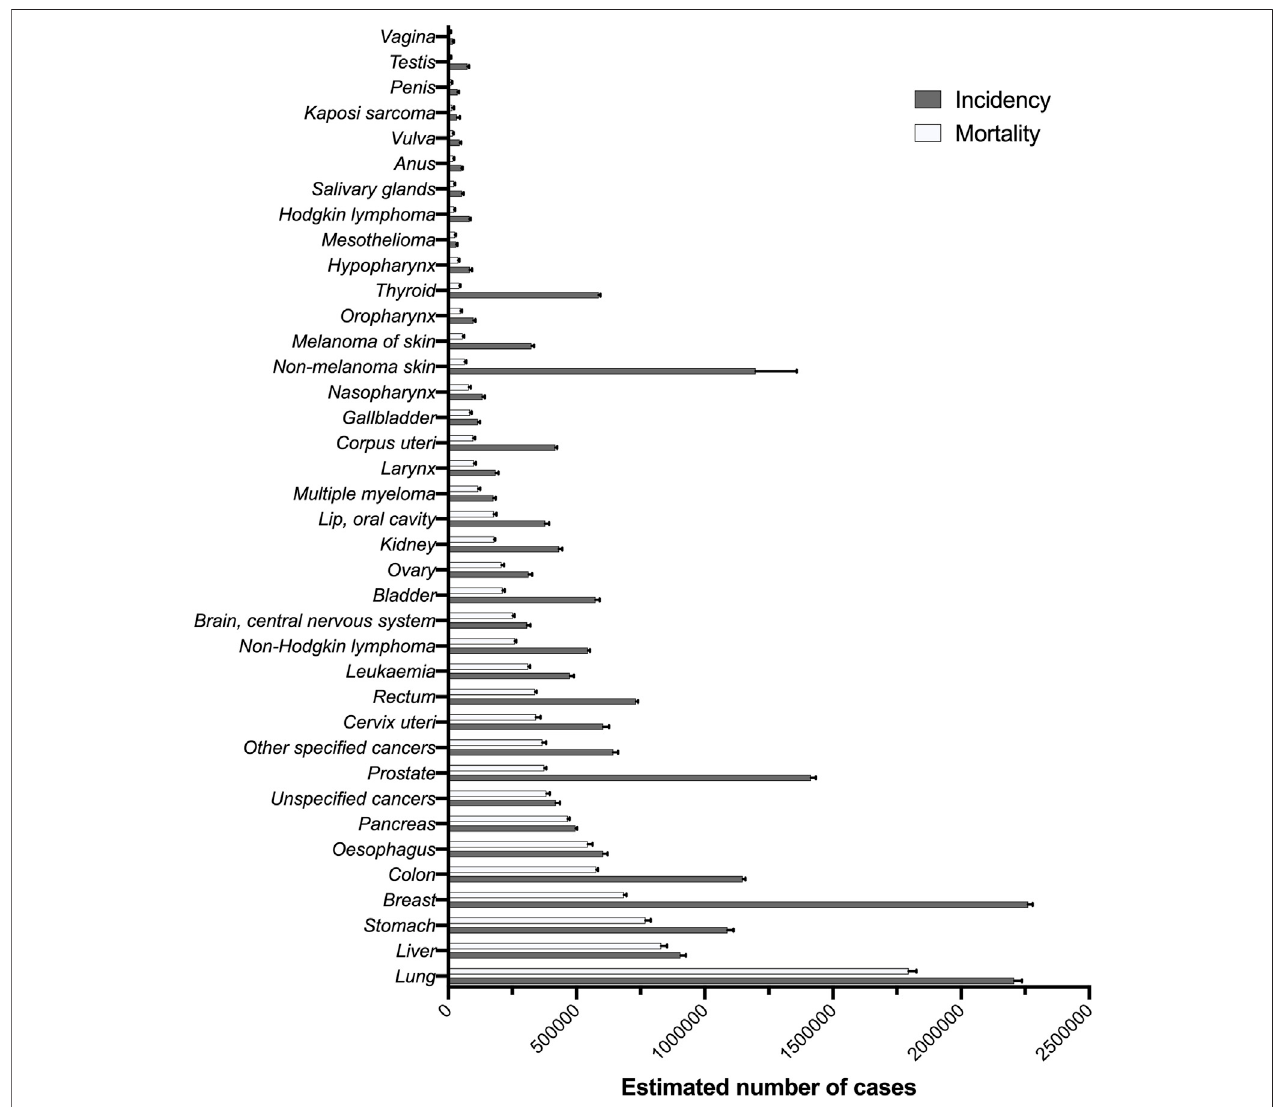
FIGURE 1 | Estimated number of new cancer cases and cancer deaths worldwide for 2020 (Ferlay et al., 2021; Sung et al., 2021).